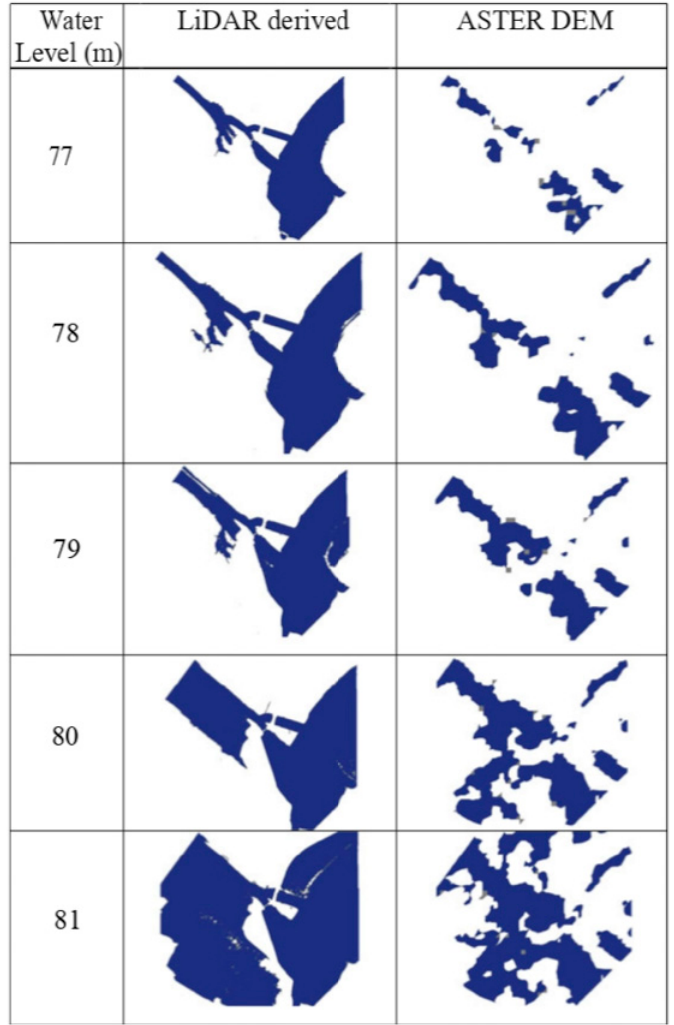
Figure 3. A comparison of flood extent derived from LiDAR and the Advanced Spaceborne Thermal Emission and Reflection Radiometer Global Digital Elevation Model (ASTER GDEM) according to water level [71].